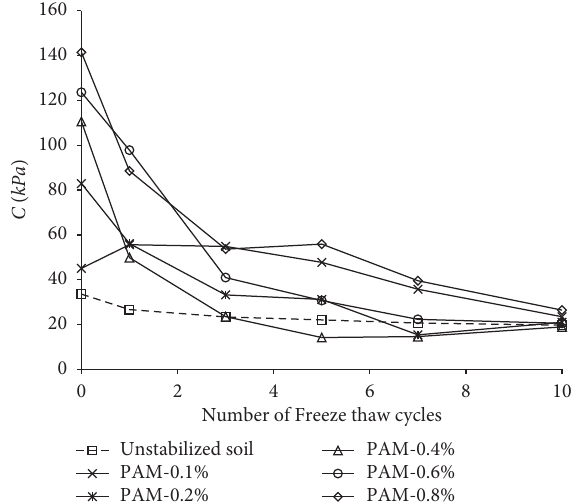
Figure 13: Changes of cohesion of PAM-stabilized samples with freeze-thaw cycles.